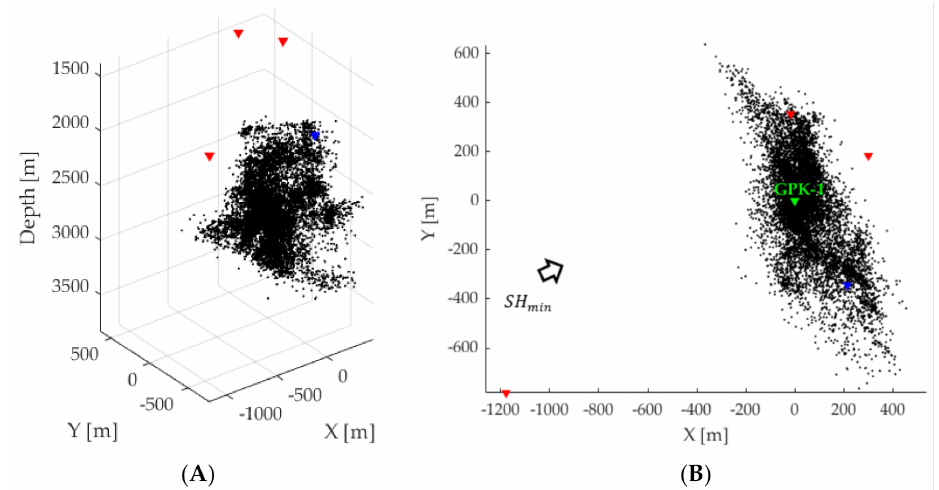
Figure 3. ( A ) Distribution of hypocenters of induced seismicity during the September 1993 injection test (black points) set against the background of the borehole network. The hydrophone is marked with a blue triangle and 4-component detectors with red triangles. ( B ) View from the top with the GPK-1 wellhead marked with a green triangle. The direction of the minimum horizontal stress is represented by SH min .